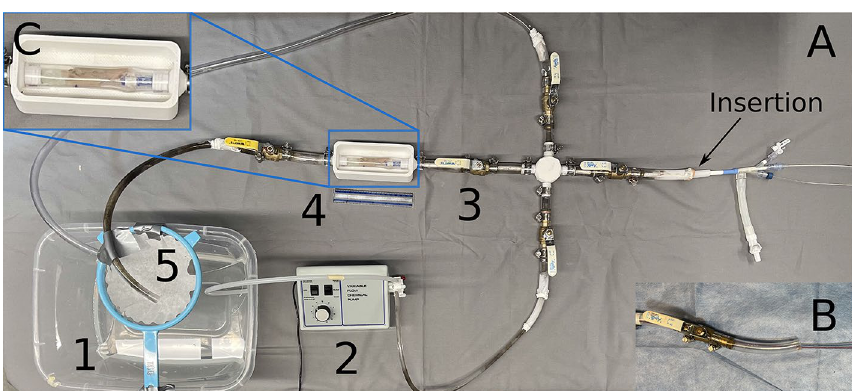
Figure 4. ( A ) The laboratory flow model consisted of (counter-clockwise, beginning in the lower left) a saline reservoir (1); a pump (2); a valve that enabled introduction of a catheter and allowed for overflow (3); a visualization chamber that supported either a clear tube or a segment of porcine vena cava with a laboratory- made thrombus (4); and a filtered return that enabled collection of any embolized thrombus (5). The MMSTC device is shown entering the setup at the insertion point. ( B ) The Penumbra device is shown entering the insertion point. C) A zoomed in view of the treatment area/thrombus model of the laboratory flow